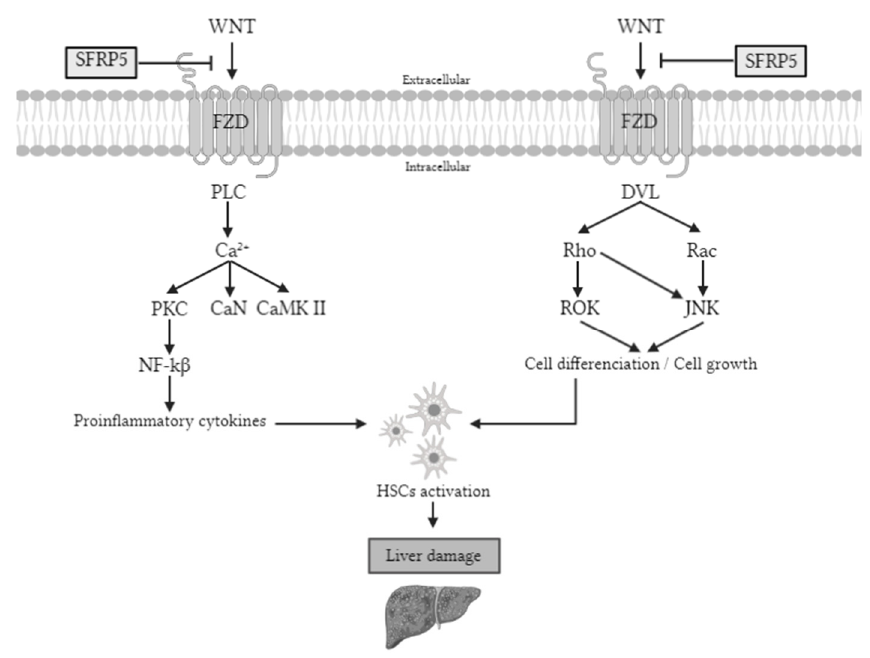
Figure 1. Noncanonical WNT pathway signaling. The WNT signaling pathway activates proteins that promote the synthesis of proinflammatory cytokines and cell differentiation. These two processes cause the activation of HSCs, which will cause liver damage if the stimulation persists. However, SFRP5 is able to inhibit the WNT signaling pathway, so the pathway is inactivated, so the liver is protected. PLC, phospholipase C; Ca 2+ , calcium 2+ ; PKC, protein kinase C; CaN, serine/threonine- protein phosphatase; CaMK II, Ca 2+ /calmodulin-dependent protein kinase II; NF-k β , nuclear factor kappa-light-chain-enhancer of activated B cells; DVL, disheveled; ROK, rho-associated protein kinase; JNK, Jun N-terminal kinase; Wnt, wingless-MMTV integration site; Sfrp5, secreted frizzled-related protein 5; FZD, frizzled receptor; HSC, hepatic stellate cells.